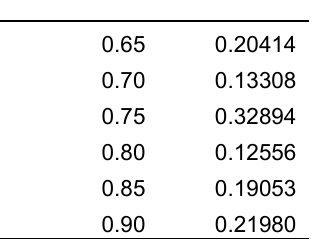
Table 4. Mean of Acceleration at different Alpha Value.